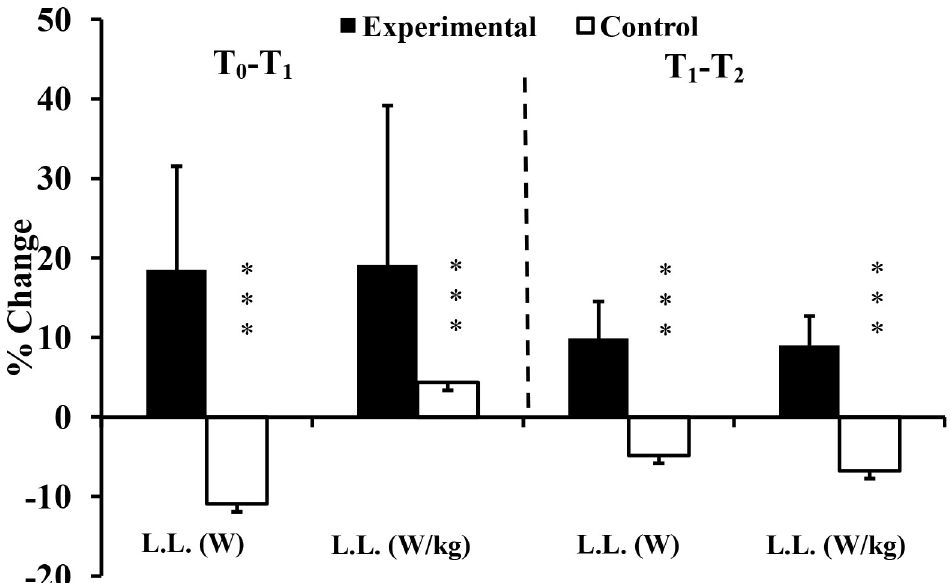
Fig 2. Percentage changes of upper limb power at T 1 , and T 2 for Experimental (E) and Control (C) groups. T 0 : before training; T 1 : after 10 weeks of resistance training; T 2 : after 2 weeks of tapering; L.L: lower limb; ��� : ANOVA group x time interaction significantly different between E and C at the level of p < 0.001.